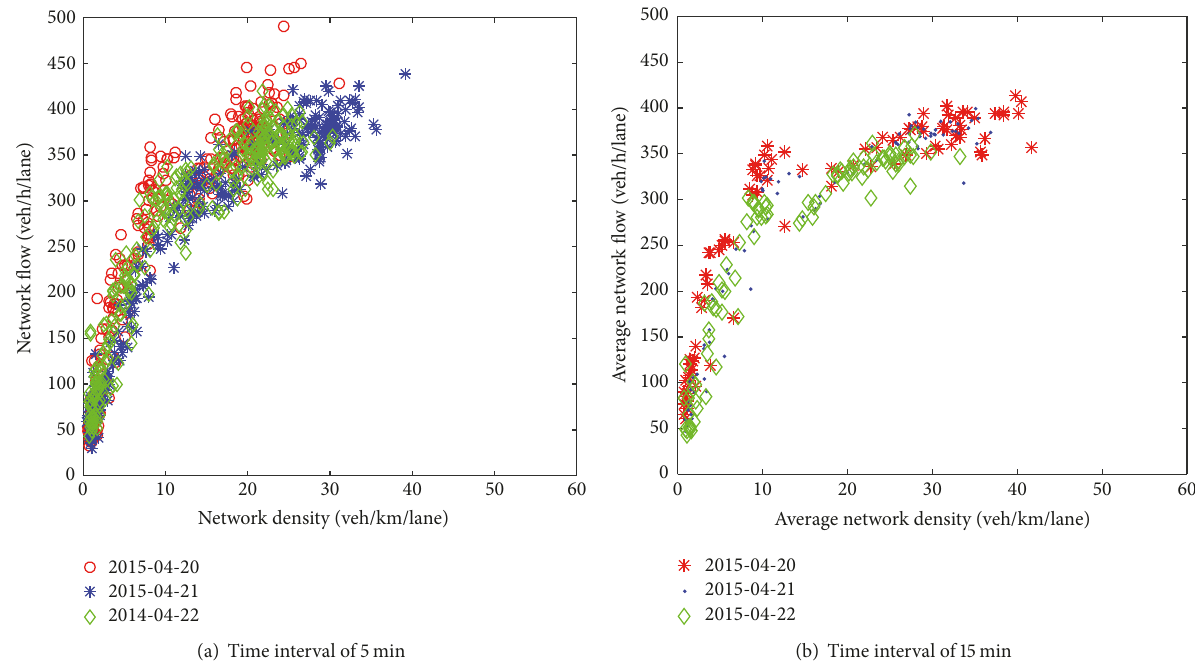
Figure 5: Network flow-density diagram for the study area in Changsha City (7:00 a.m. − 7:00